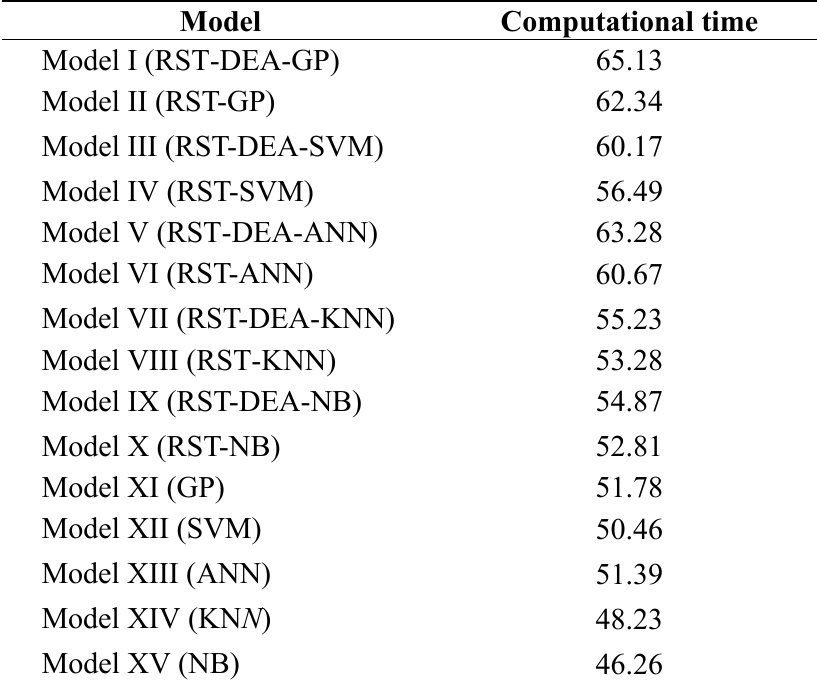
Table 14. Computational time of different models